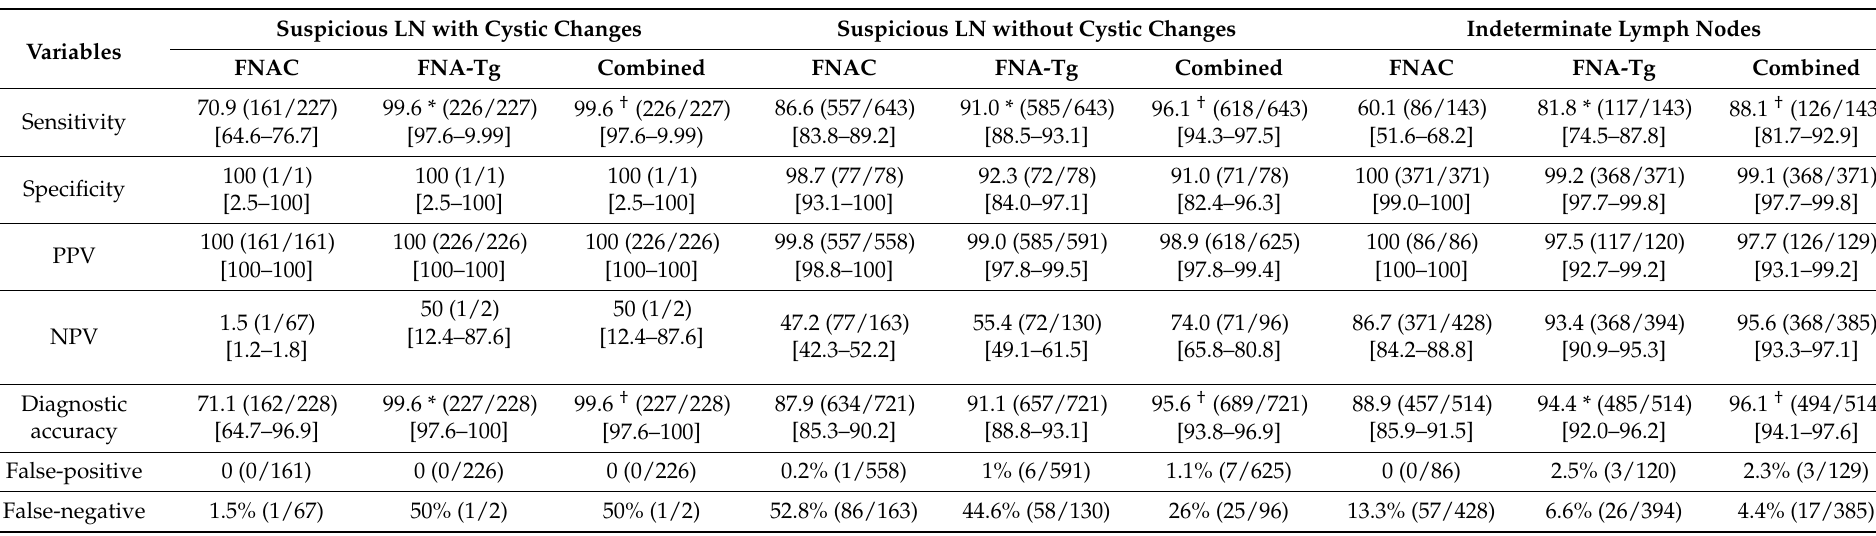
Data are percentage with proportion in parentheses and 95% confidence index in brackets unless otherwise indicated. Cutoff for Tg-FNA were 8.3 µ g/L preoperatively, 0.97 µ g/L following lobectomy, and 1.1 µ g/L following total thyroidectomy. * p < 0.025 for comparisons of FNAC and FNA-Tg. † p < 0.025 for comparisons of FNAC and combined FNAC and FNA-Tg. LN, lymph node; FNA, fine-needle aspiration; Tg, thyroglobulin; PPV, positive predictive value; NPV, negative predictive